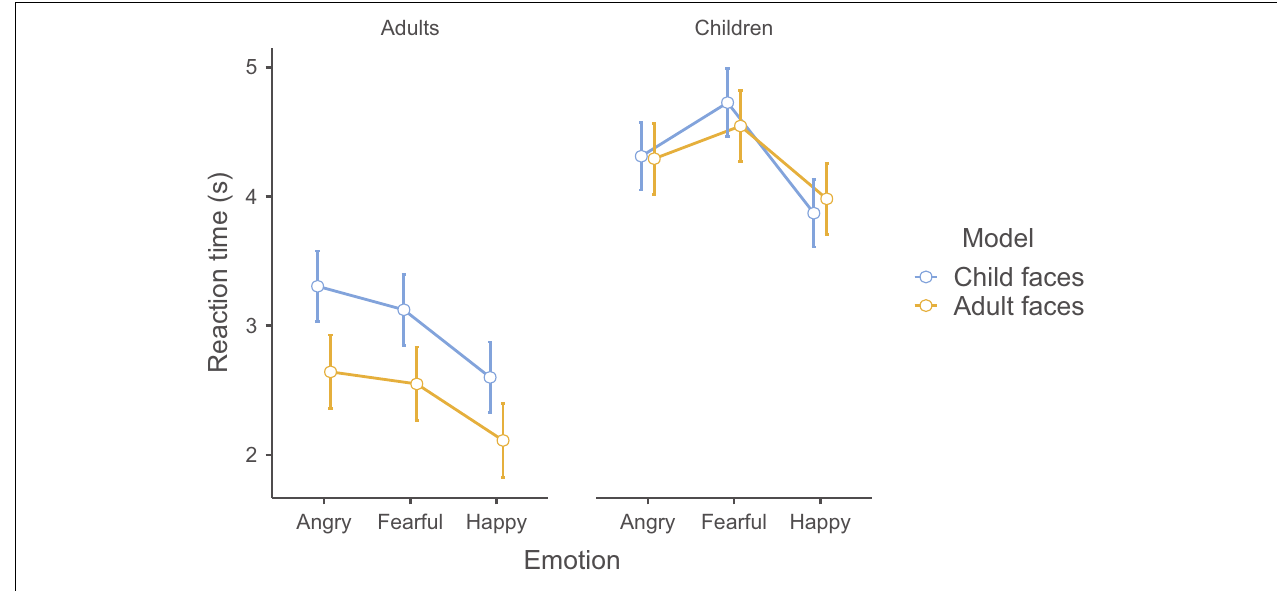
FIGURE 1 | The three-way interaction between Emotion, Group, and Model. The significant effects were the main effect of Emotion, Group, and Model as well as the two-way interactions between Emotion and Group and between Group and Model. The results are in seconds; 95% confidence intervals are shown.